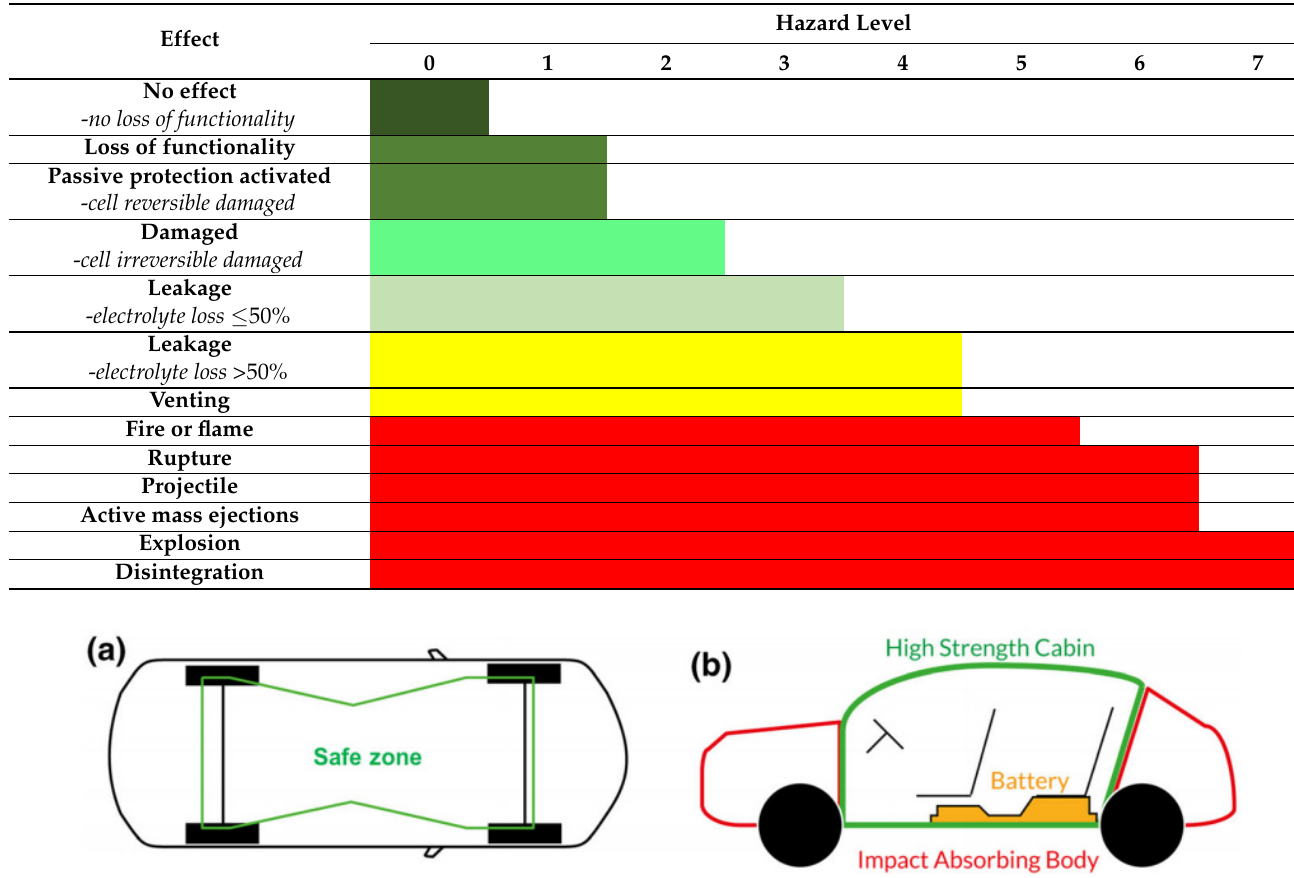
Figure 3. Protection of the battery pack in EVs: ( a ) Safe zone for battery pack; ( b ) impact absorbing zone for reducing the risk of penetration during the crash accidents [15].